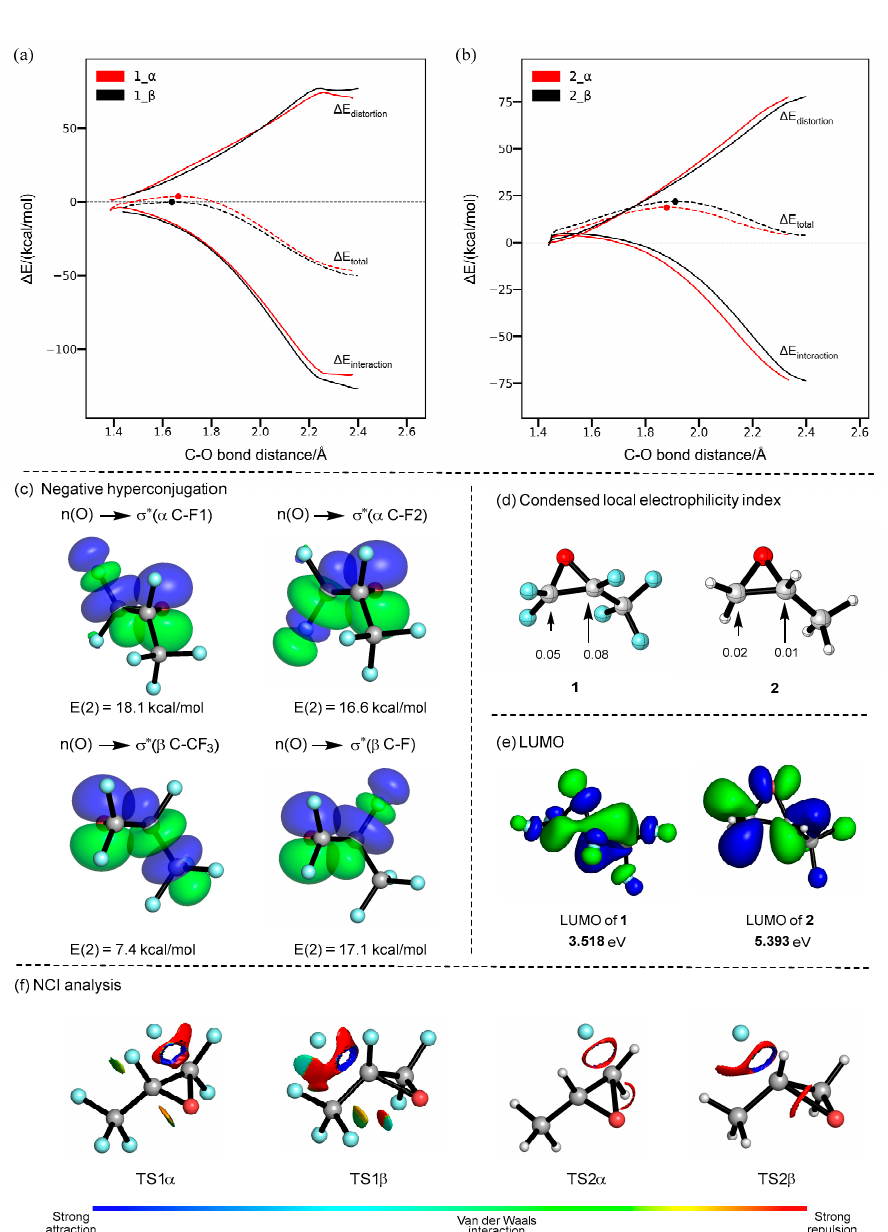
Figure 2. DIAS analysis for the ring-opening reaction of 1 ( a ) and 2 ( b ). The electronic energy values are projected on the distance between the breaking C-O bond (positions of TS indicated with a dot). There is only one curve showing the distortion energy for the case where F − is not distorted along the reaction coordinate; ( c ) The key donor-acceptor orbital interactions of 1 obtained by NBO analysis at the ω B97X-D/6-31G(d,p)-SMD-(ethyl ether) level; ( d ) The condensed local electrophilicity indexes of the epoxide carbon atoms; ( e ) The lowest unoccupied molecular orbital (LUMO) isosurfaces of 1 and 2 ; ( f ) NCI analysis for the four transition